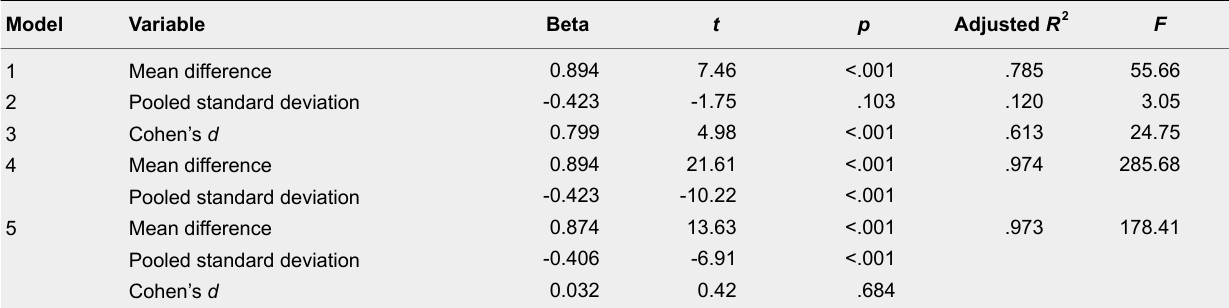
Results of the Multiple Regression Analyses on Average Ratings in Experiment 2